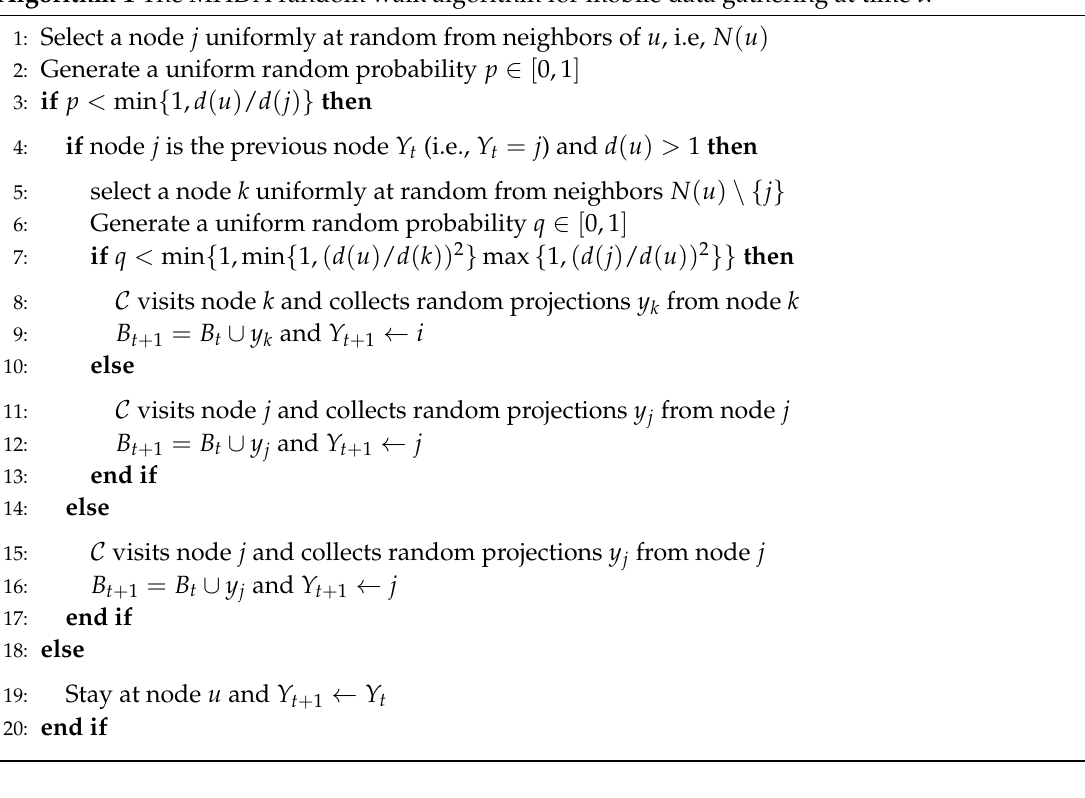
Algorithm 1 The MHDA random walk algorithm for mobile data gathering at time t